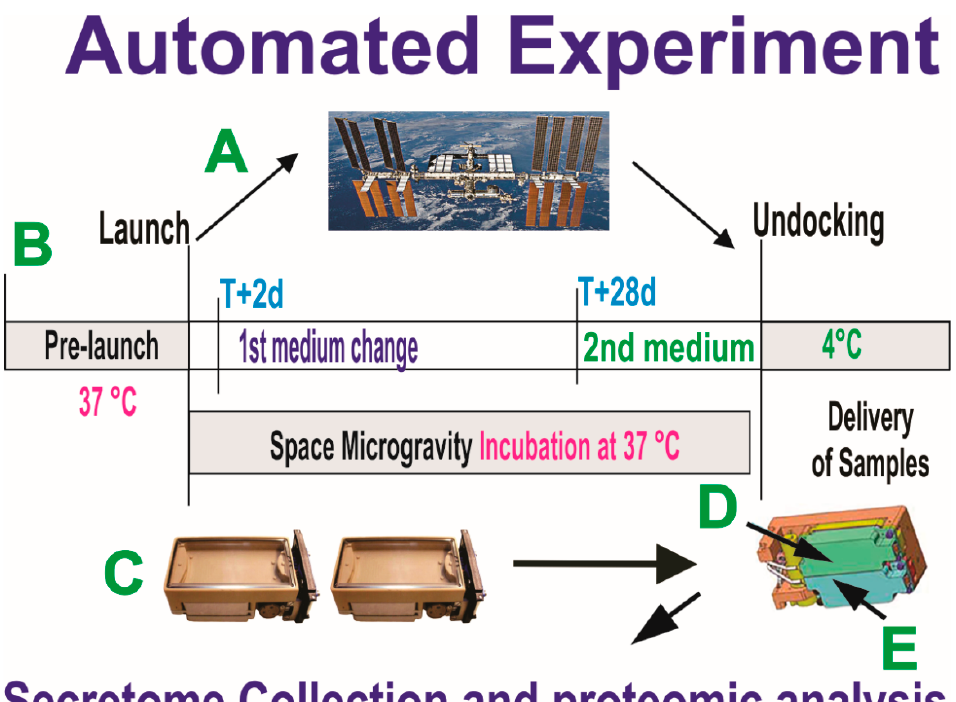
Figure 3. Synopsis of the automated experiments. OLPs, as part of the Bioscience-4 Space Biology NASA experiment, flew to the ISS ( A ) on board SpaceX-16, together with the passive experiments. ( B ) Timeline on when the conditioned medium (secretome) for the initial portion of the flight was removed on T+2 d after OLPs reached space. This medium was in contact with the cells for 26 days, at which time the second culture medium was recovered into the second tank just prior to unberth, in order to capture the molecules secreted solely while cells were onboarding the ISS. During ascent, descent, and space flight, cells were maintained at 37 °C. Upon arrival to our laboratory, the culture medium that fed the cells during space flight (secretome) was recovered from the hardware separately, the medium from each well was recovered separately and placed in numbered tubes with addition of proteases inhibitor cocktail, and saved frozen at − 80 °C. ( C ) View of the cell chamber where mesh carriers with cells and the travel culture medium travelled. ( D , E ) Tanks that contained the fresh medium to be released at T+2 to start the experiment. Tank 2 (E arrow) contained the second fresh medium with which the cells came back to Earth.